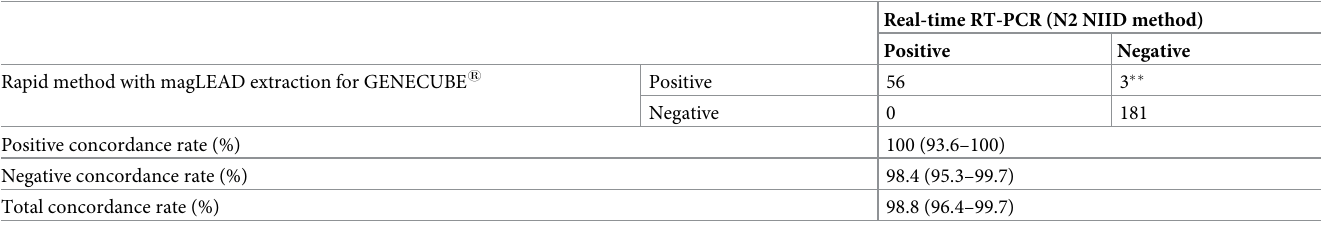
Table 8. Concordance rate of the rapid method with magLEAD extraction for GENECUBE 1 with real-time RT-PCR for saliva samples �